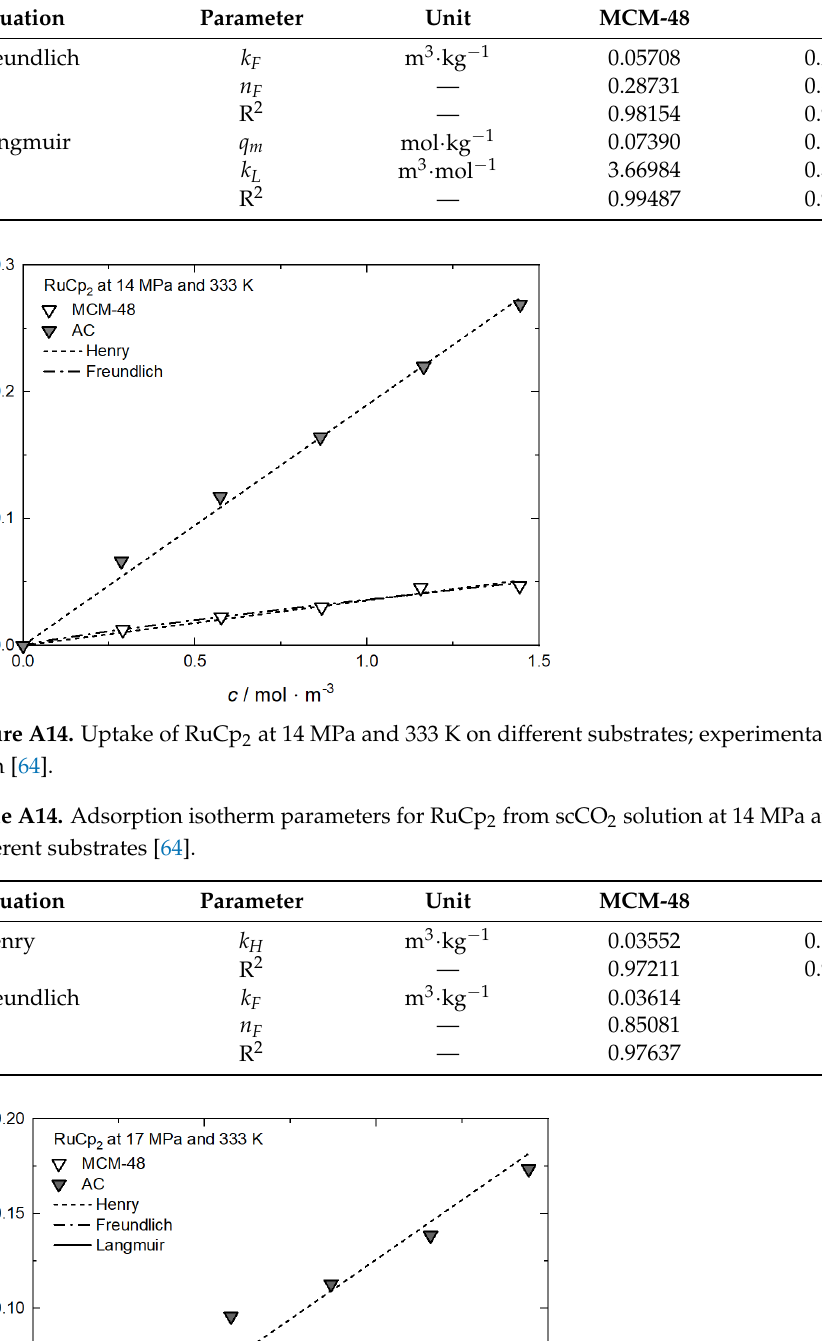
Table A13. Adsorption isotherm parameters for RuCp 2 from scCO 2 solution at 11 MPa and 333 K on different substrates [64].